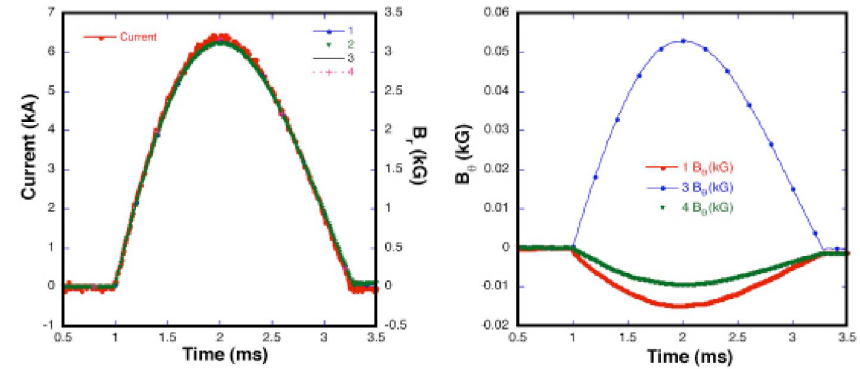
FIG. 22. (Color) Magnet current along with the integrated and calibrated radial field (left panel), and the corresponding azimuthal field (right panel).